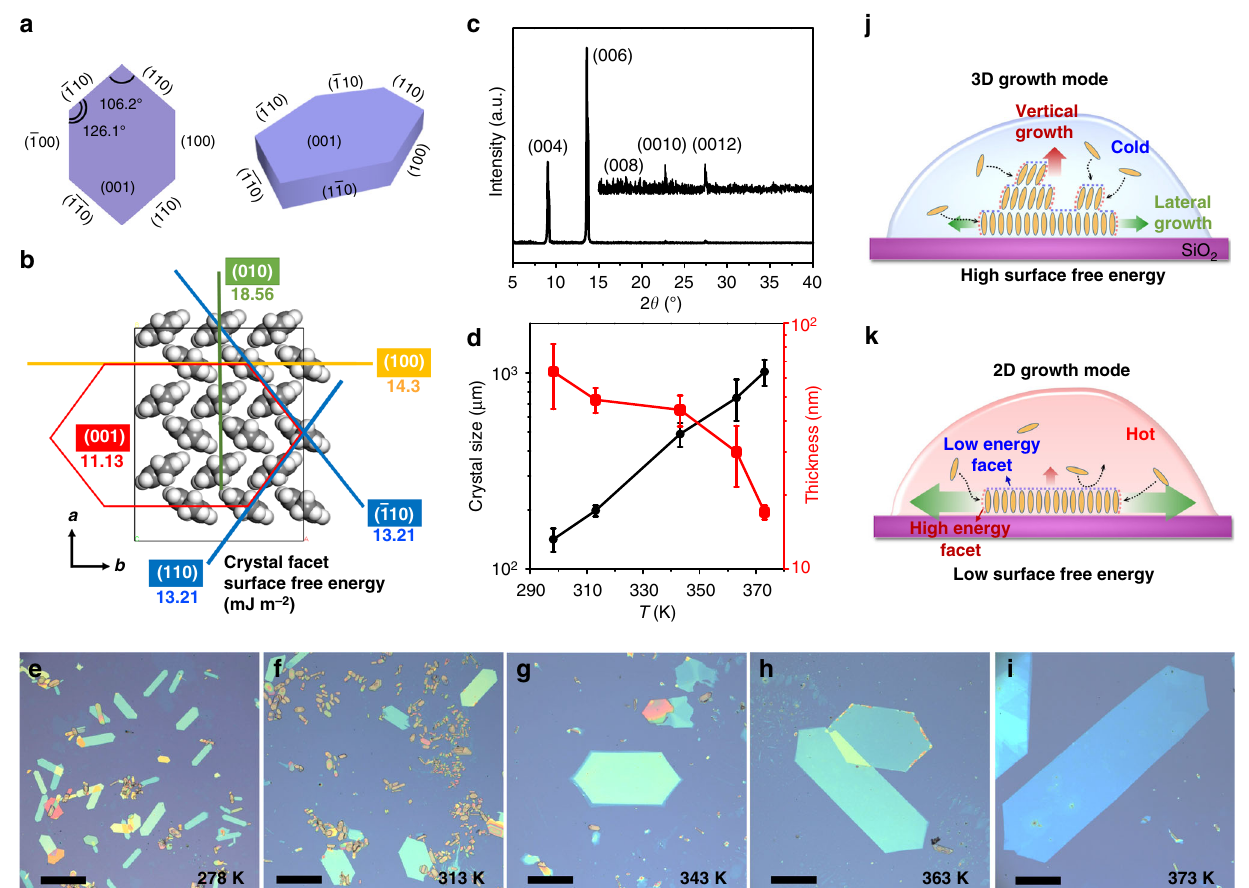
Fig. 3 Thermodynamical epitaxial growth of 2D p-MSB crystals. a Schematic diagrams of a p-MSB single crystal with indexed facets viewing along the c axes and at about 45° angle with respect to the c direction. b Molecular arrangement and c X-ray diffraction (XRD) pattern of the p-MSB crystal. The calculated surface-free energy of each crystal facet is shown in b . d Plots of average crystal size and average thickness with respect to the growth temperature (all crystal sizes are quanti fi ed using the diagonal length of the crystals). e – i Optical images of p-MSB crystals grown at different temperatures from 298K to 373 K. j , k Growth mechanism of two different growth modes. The ratio of the lateral growth rate to the vertical growth rate varies with temperatures. High-energy facet and low-energy facet are indicated by red and blue dashed lines, respectively. The thermodynamically controlled 2D growth mode can reach a surface energy minimum. The scale bars in e – i are 200 μ m. The error bars in d represent the standard error of the mean (s.e.m.) of the average size or the average thickness of the crystal measured from the optical or AFM